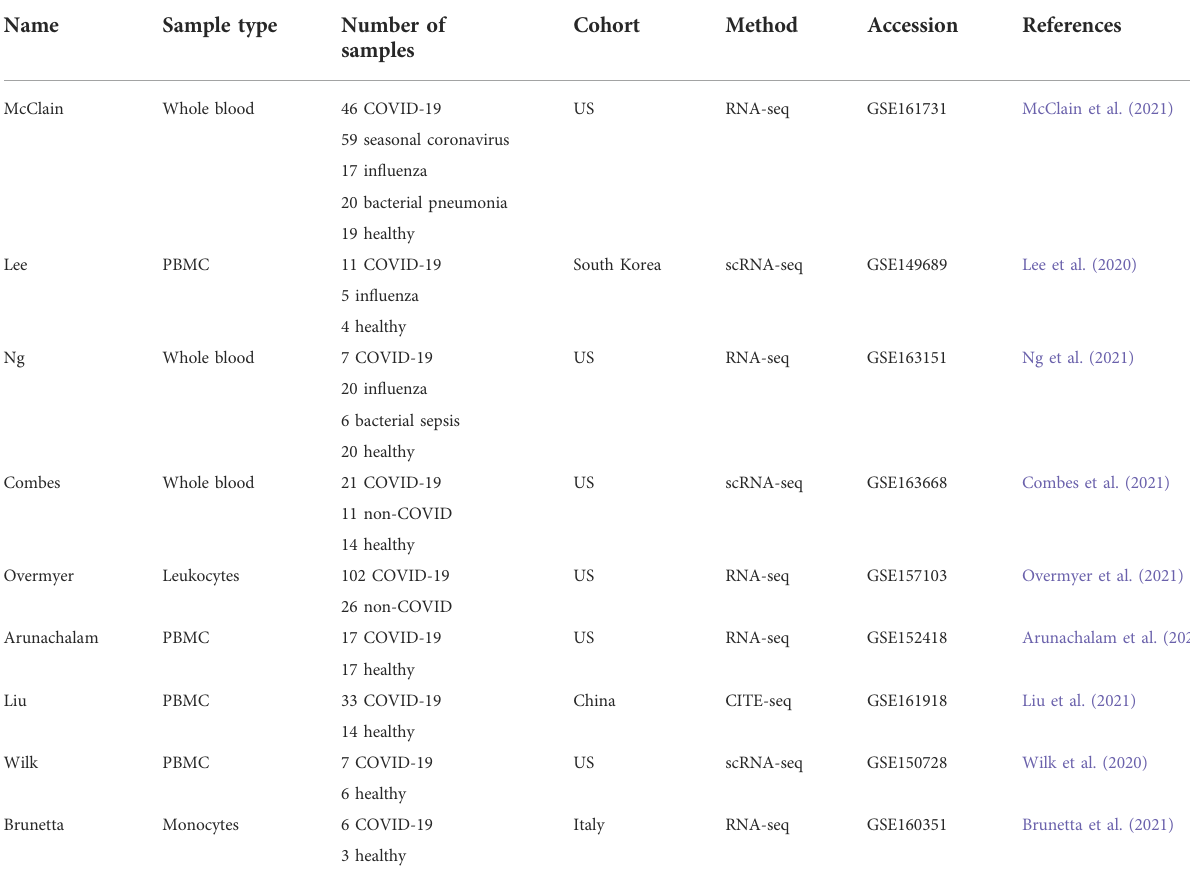
TABLE 1 Datasets used in this